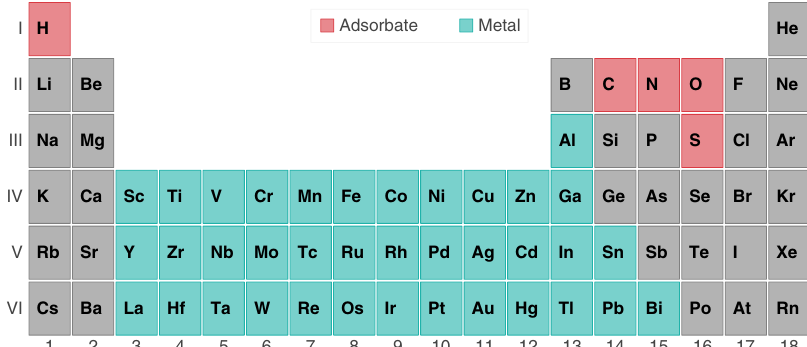
Fig. 8 The periodic table showing the 37 transition metals and 5 adsorbates used in this study. Elements highlighted in light blue color indicates 37 transition metals that were used to form A 1 , L1 0 , and L1 2 alloys and pink color indicates the atoms used as the